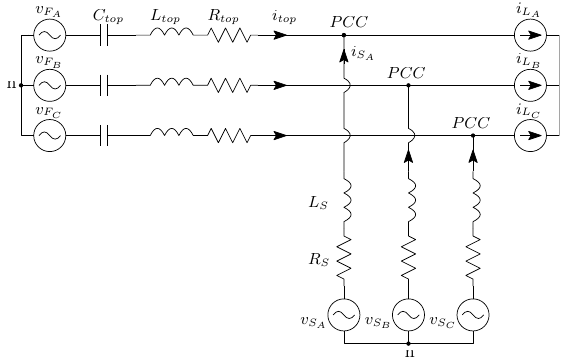
Figure 2. Equivalent circuit for the fundamental ac